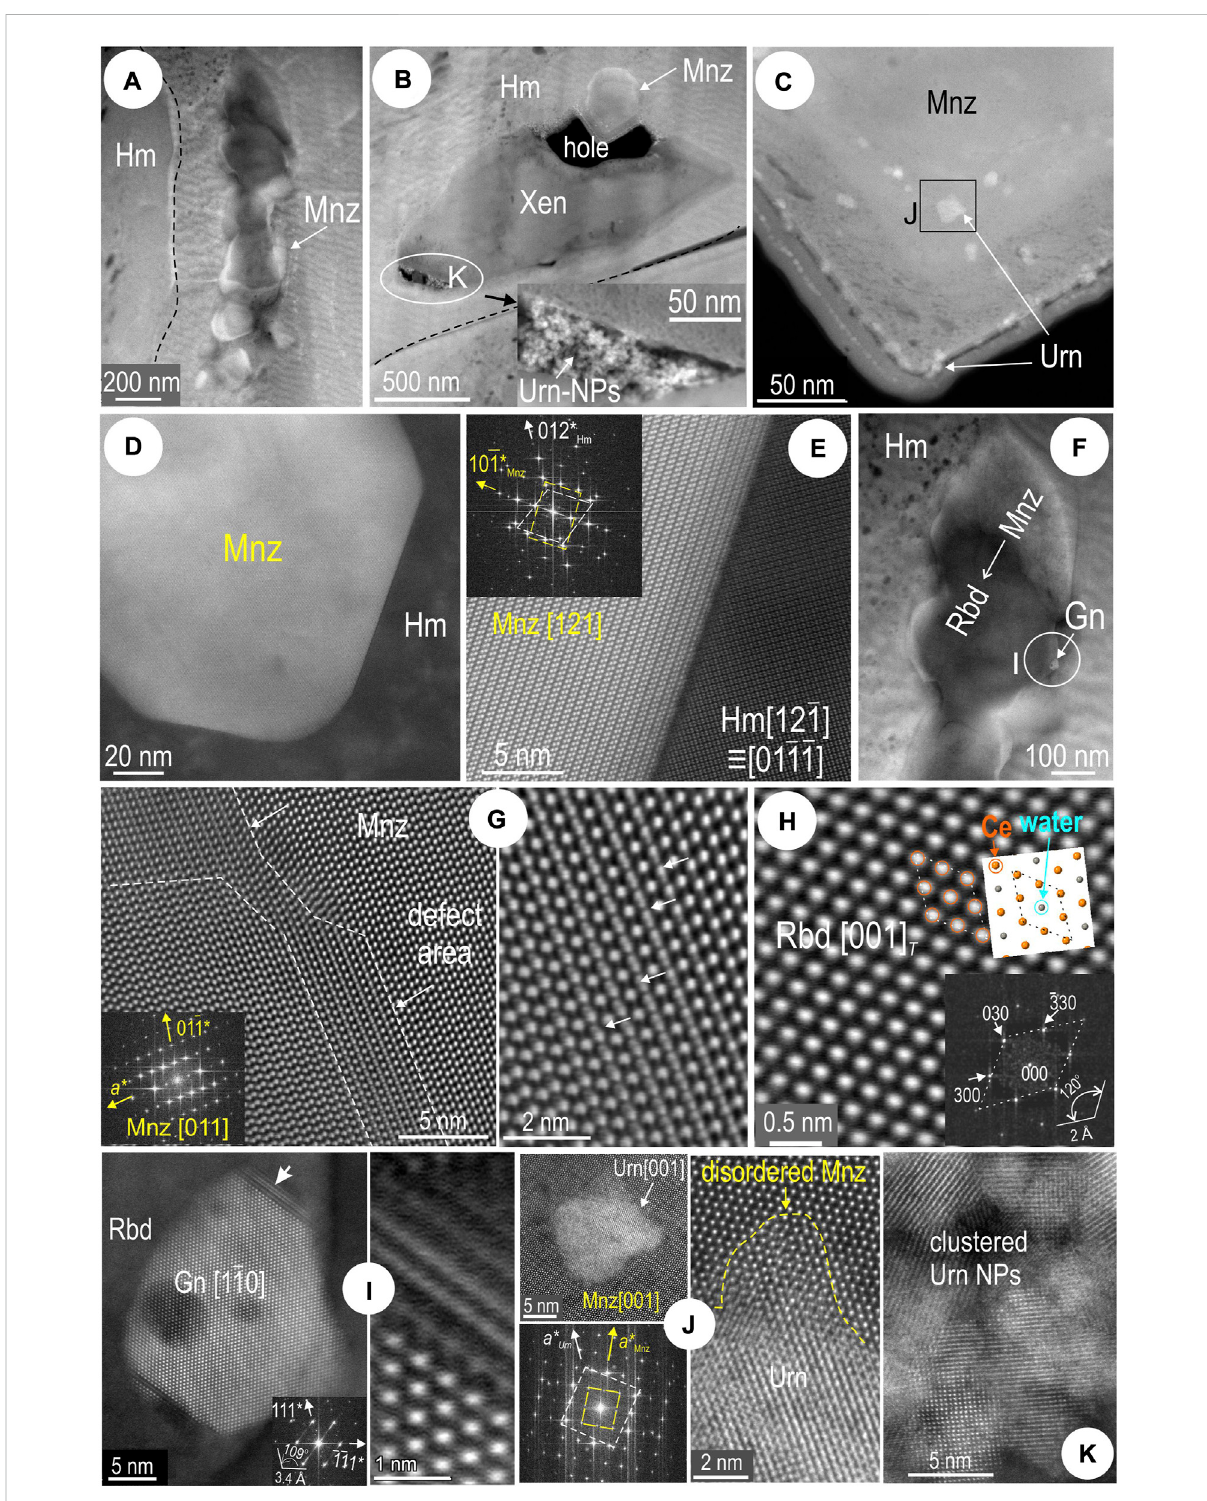
FIGURE 13 HAADF STEM images of inclusions in hematite (Hm) from sample 3Ta (foil Hm#2). Zone axes given in square brackets and orientation as FFT patterns (insets). (A) Monazite (Mnz) string (mapped in Figure 12A) along lamellae boundaries. Note a “ streaky ” fabric in hematite. (B) Xenotime (Xen) withmarginalmonazite(top)anduraninite(Urn)(bottomandinset). (C) UraniniteNPsinmonazitefromgrainatthetopofxenotime. (D,E) Congruent boundary between monazite and hematite. (F) Contrast changes in monazite undergoing transformation rhabdophane (Rbd). Gn ─ galena. (G) High-resolution images of defect area within monazite. (H) Atomic-scale image and FFT pattern allowing identi fi cation as rhabdophane. The structure model (inset) shows a rhombic motif of Ce atoms with “ water ” at the centre, absent on the image (Ce atom overlay). (I) Detail of galena NP shown in (F) . (J) Single uraninite NP with disordered monazite in boundary domain. (K) Clustered uraninite NPs [from inset in (B)